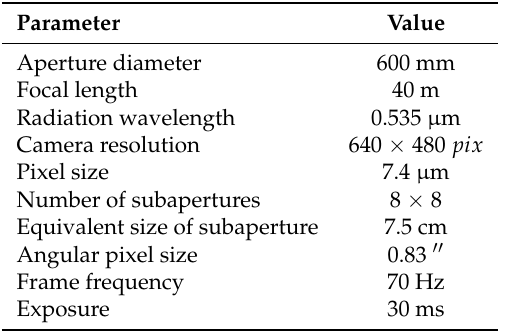
Table 2. Main parameters of the large solar vacuum telescope and Shack–Hartmann wavefront